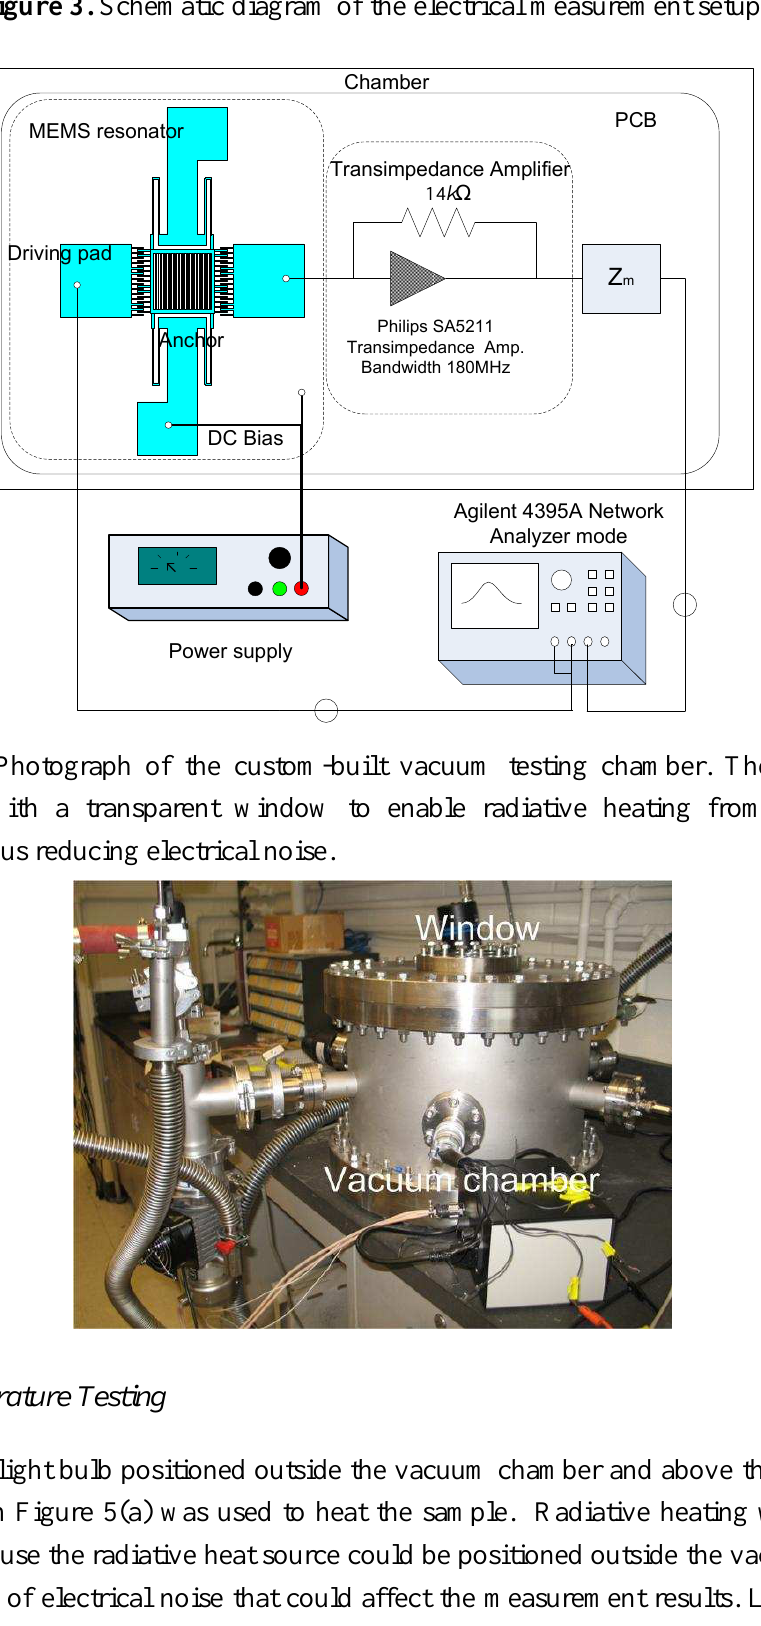
Figure 3. Schematic diagram of the electrical measurement setup.